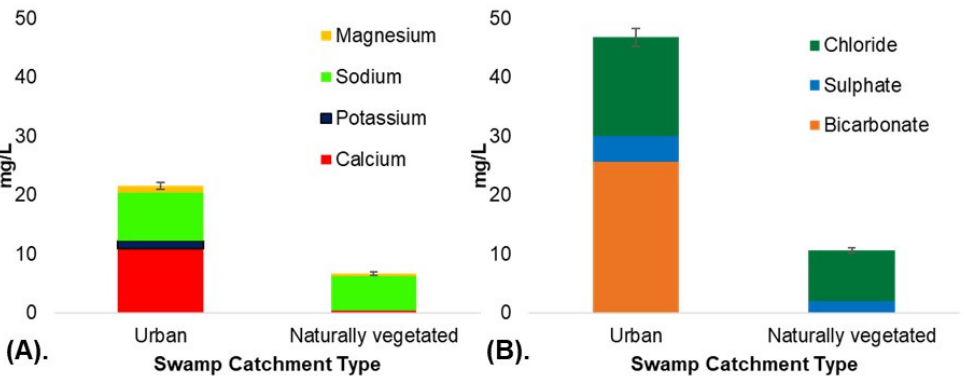
Figure 2. Comparison of the mean (+/ − standard error) ionic signature of water in urban ( n = 4) and